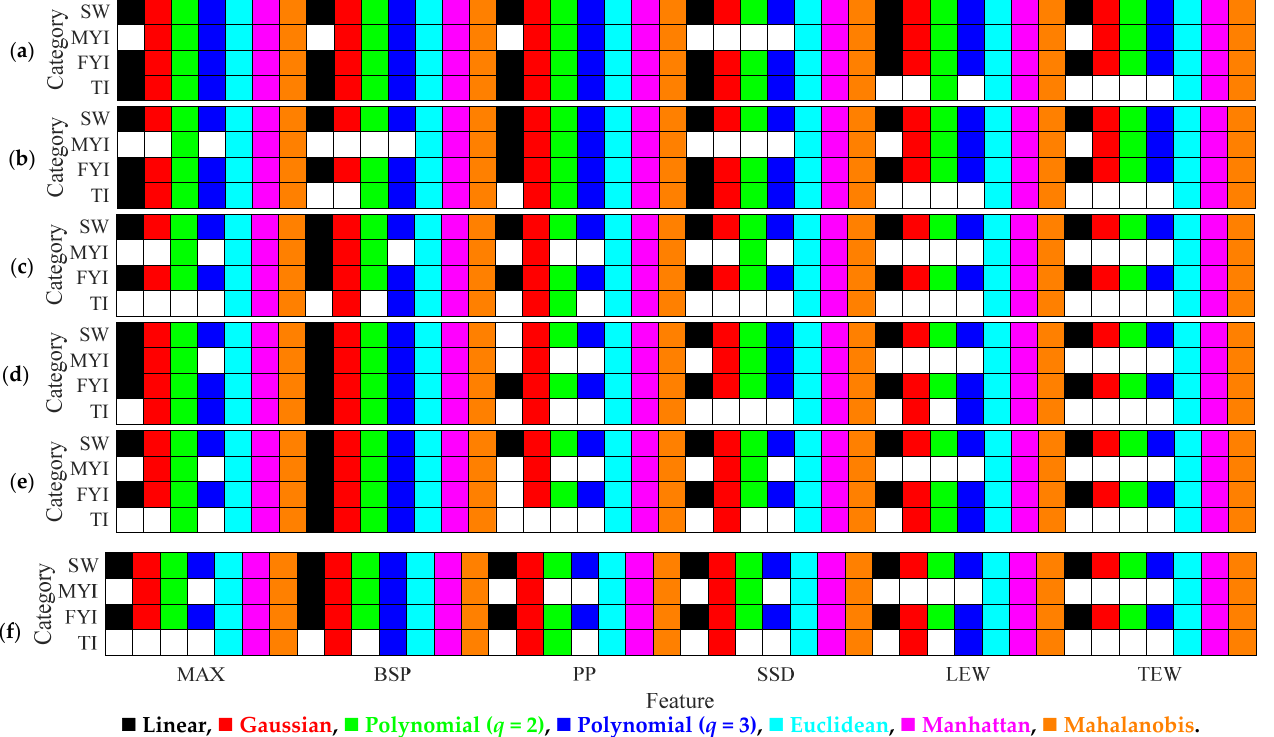
Table 4. Overall accuracies of waveform features at small incidence angles using the Euclidian